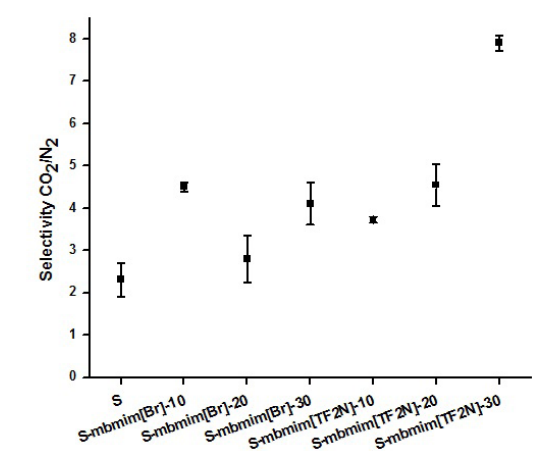
Figure 6. Selectivity at 2.3 MPa of pressure and 45°C of temperature.